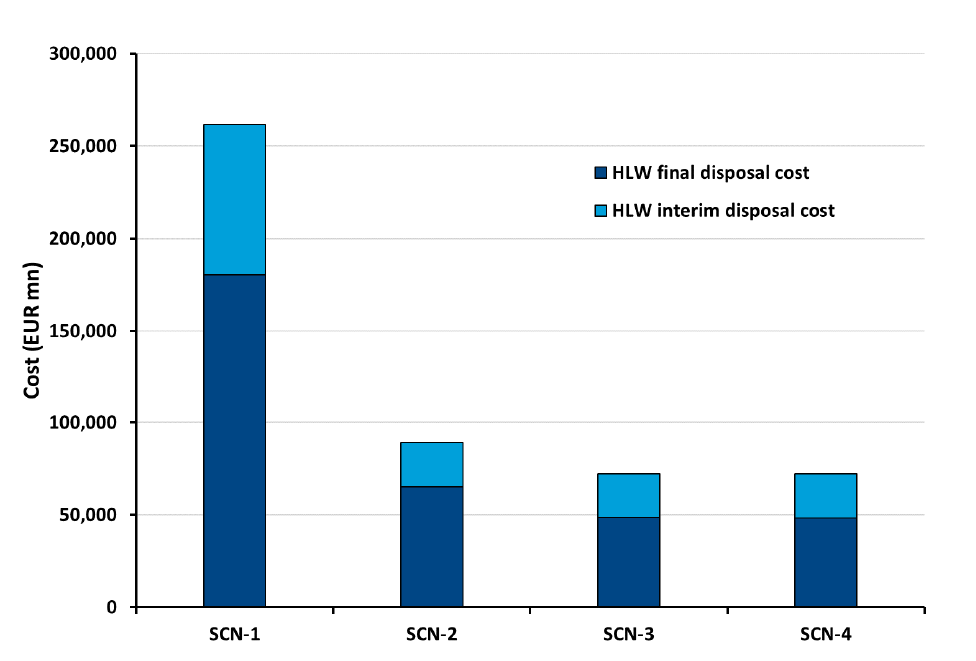
Figure 10. HLW interim (ID) and final disposal (FD) costs for various scenarios. SCN-1 is the OTC; SCN-2 is the transition to SFR with Pu fuels by 2100; SCN-3 is the same as SCN-2 but includes MA transmutation in SFR and SCN-4 includes SFR for Pu and ADS for MA [38]. Table 9. LFCC calculations for fuel cycle scenarios analysed by Ko and Gao